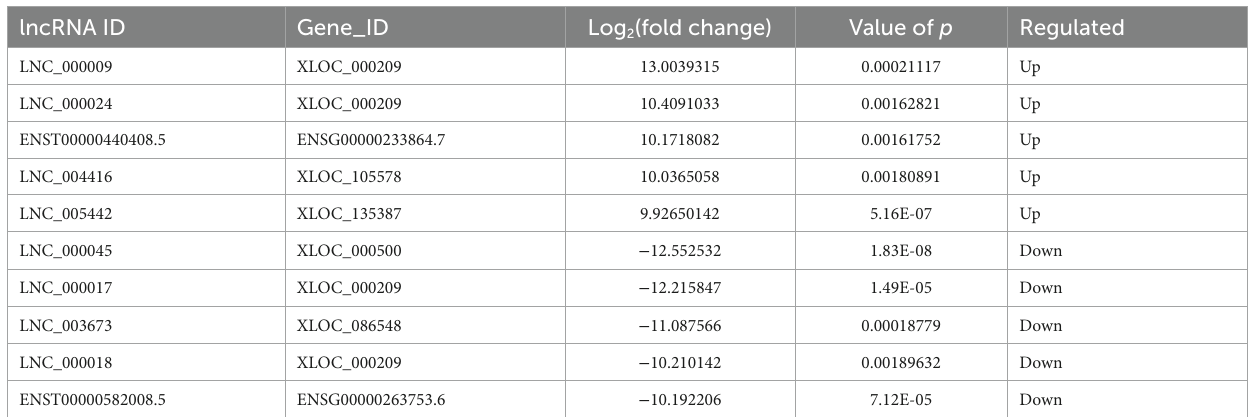
TABLE 5 The top 10 DE